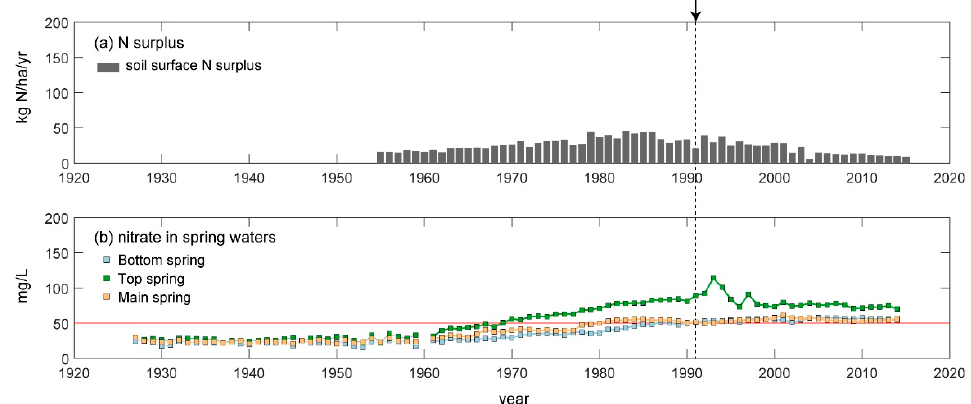
Figure 6. Overview of the soil surface N surplus ( a ) and annual average concentrations of nitrate of groundwater (spring) of La Voulzie ( b ). The figure annotations are the same as those of Figure 4.